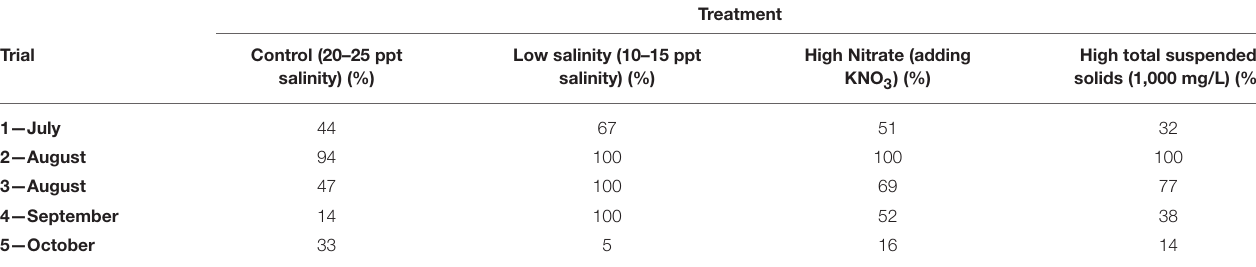
TABLE 1 | Percent ratio of Vibrionaceae to total aerobic bacteria in oysters subjected to laboratory experiments throughout the months of July through October.